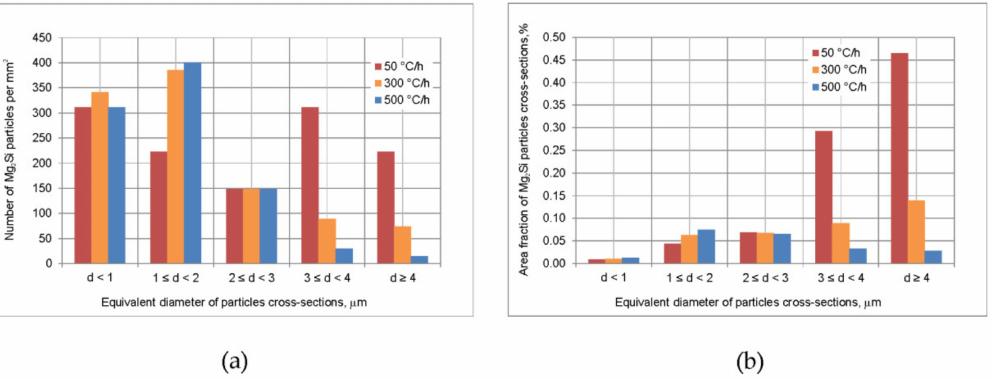
Figure 8. Effect of cooling rate from homogenization temperature on: ( a ) number of β -Mg 2 Si particles per mm 2 and ( b ) area fraction of β -Mg 2 Si particles